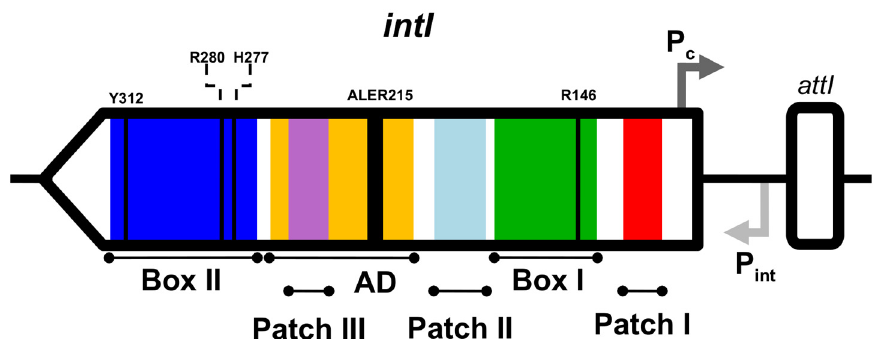
Figure 1. Integron structure. intI integrase gene is depicted with a horizontal black arrow; Pc, gene cassette promoter in dark gray, Pint, integrase promoter in light gray; attI recombination site with a white rectangle. Colored sections of the integron depict key regions: Box I in green, Box II in blue, Patch I in red, Patch II light blue, Patch III in purple, and the Additional Domain (AD) in yellow. The tetrad RHRY is represented with thin black lines and the conserved motif ALER215 with a thick black